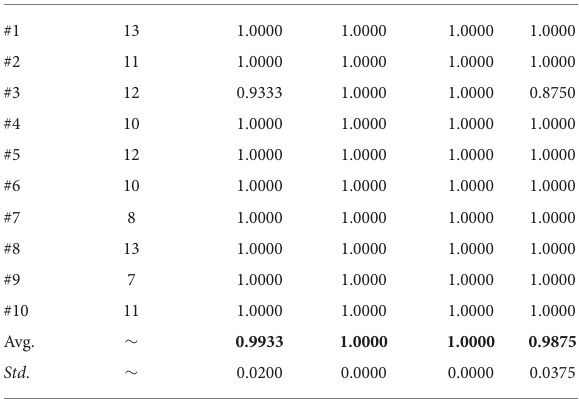
TABLE 14 The detailed results acquired by